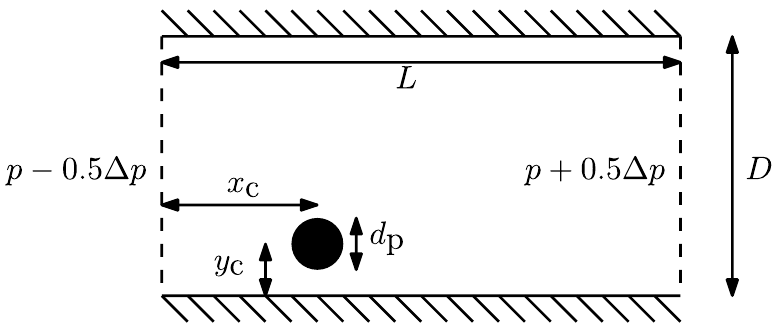
Figure 8. Computational domain for the investigation of the tubular pinch effect.